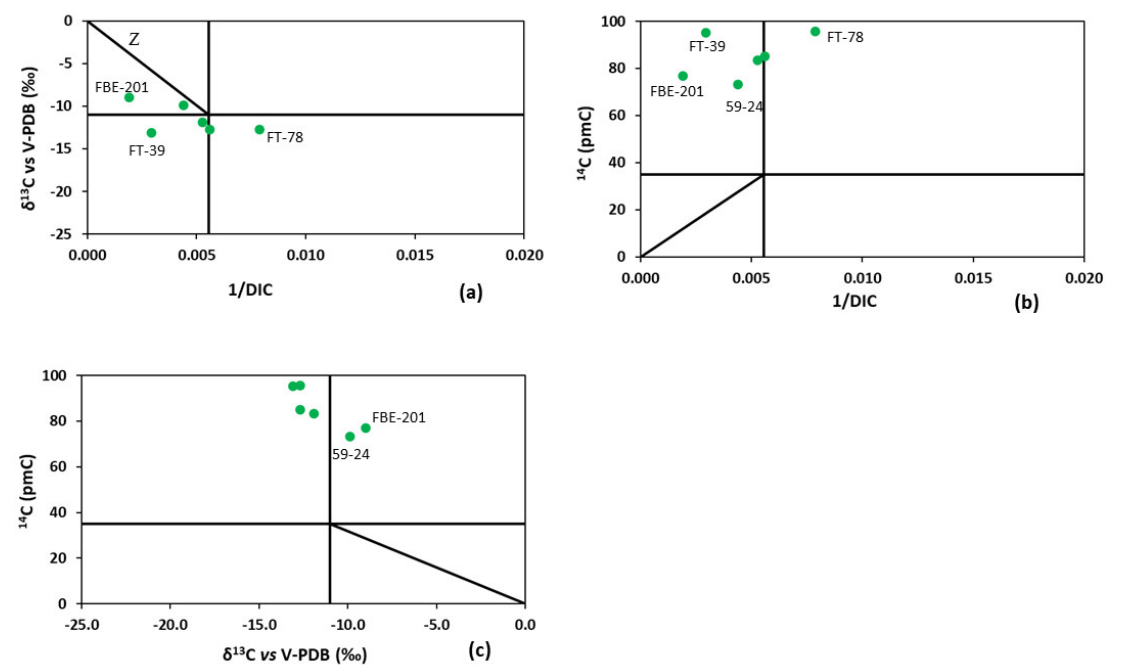
Figure 12. Graphical method to evaluate predominant geochemical processes occurring in ground- water samples from Santiago Island (Middle Unit) for radiocarbon dating ( a ) δ 13 C vs. 1/DIC; ( b ) 14 C vs. 1/DIC; ( c ) 14 C vs. δ 13 C.